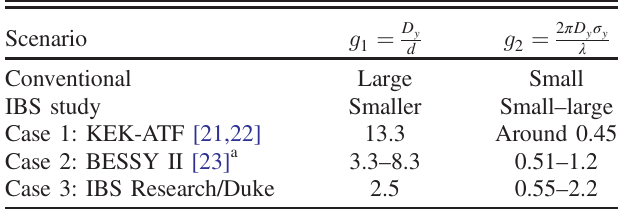
TABLE I. Comparison of the figures of merit between conven- tional SRI systems and a system for beam instability studies. Case 1 is the vertical beam size measurement system at KEK-ATF [21,22] and Case 2 is the beam measurement system at BESSY-II [23]. Case 3 is the new SRI system designed for the IBS research at the Duke storage ring.